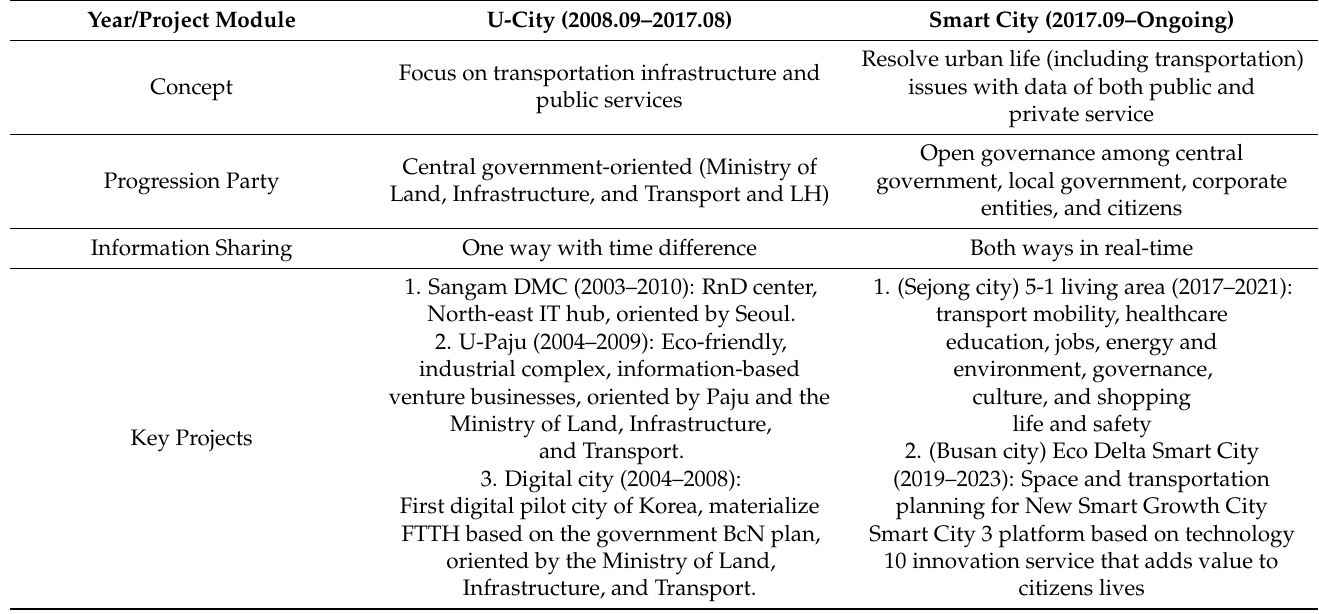
Table 3. Comparison between U-city and Smart City